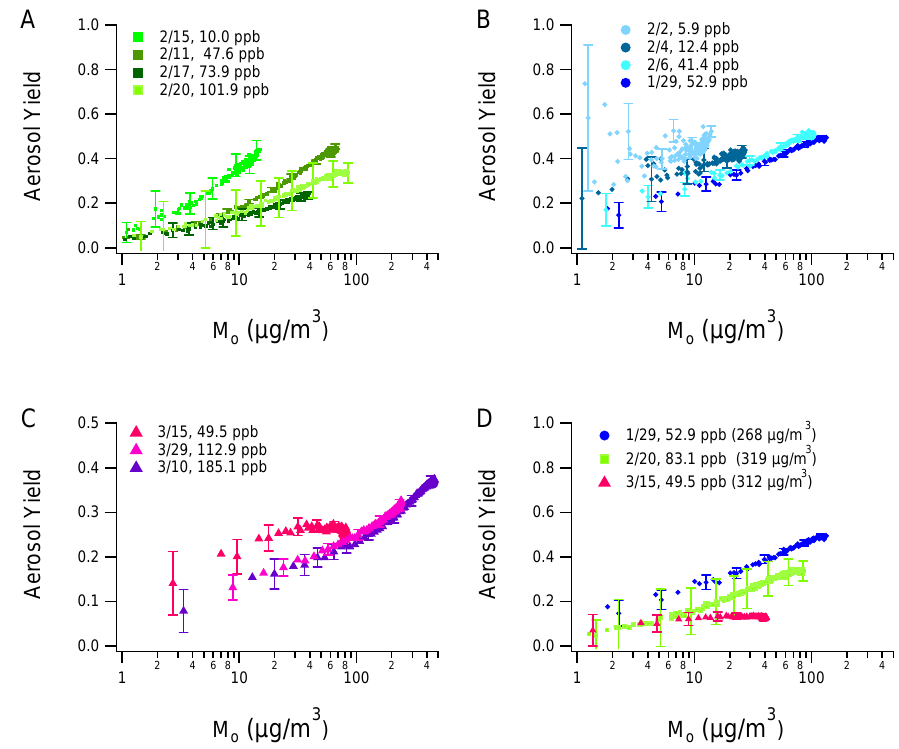
Fig. 1. Aerosol yields as a function of organic aerosol mass for (A) phenol (squares), (B) guaiacol (circles), and (C) syringol (triangles). (D) Comparison across systems for similar amounts of reacted hydrocarbon by mass concentration.